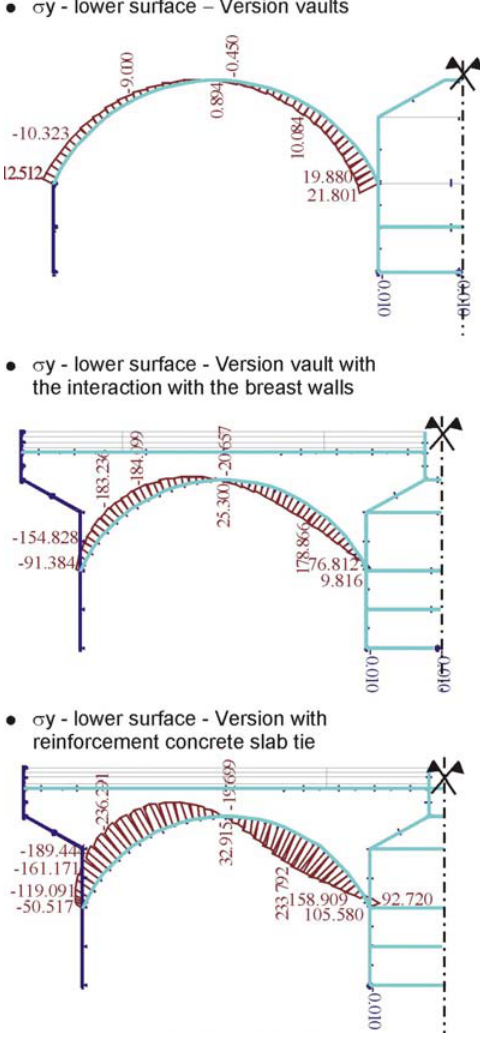
Fig 8. Comparison of normal stress σ y values in a charac- teristic cross section of stone bridge